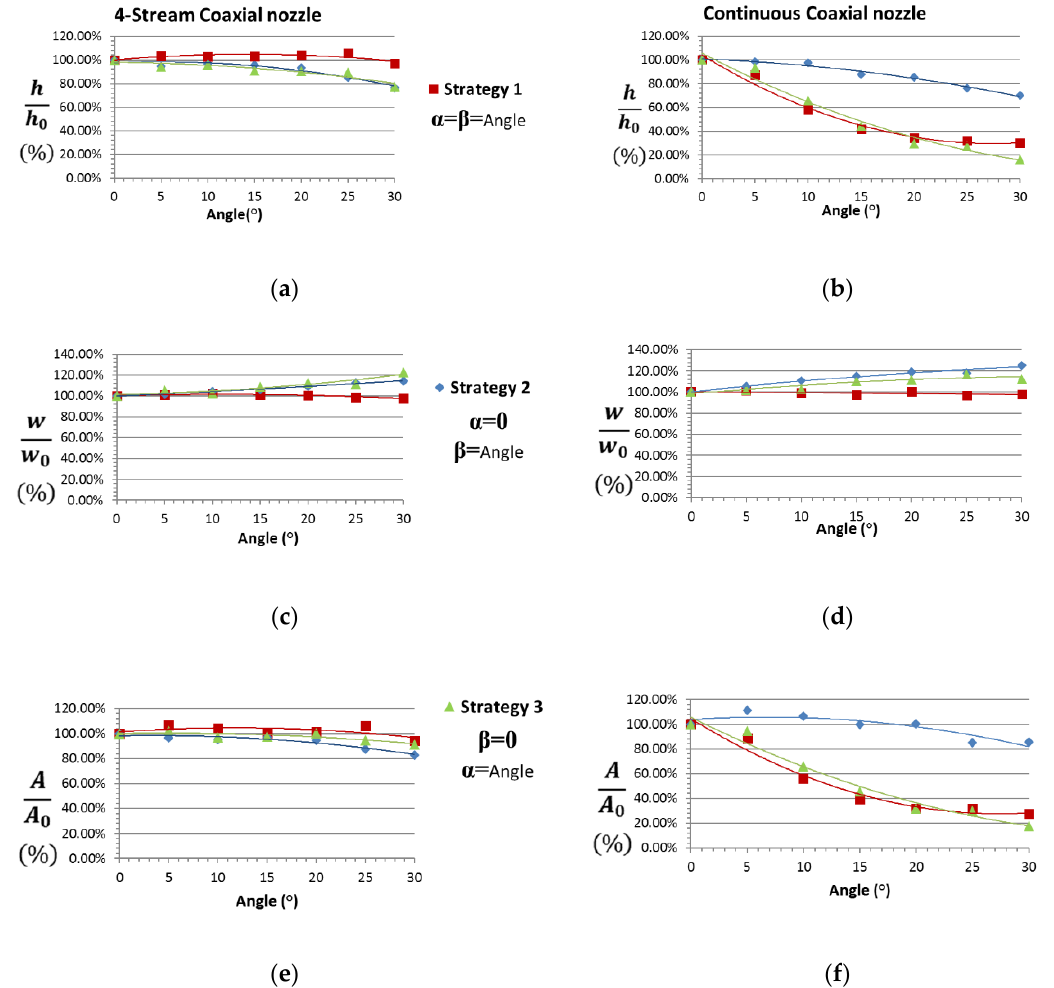
Figure 10. Evolution of the clad dimensions (height, width, and area), in relation to the control clad (α = 0, β = 0), at 500 mm·min −1 : ( a , c , e ) four-stream nozzle; ( b , d , f ) continuous coaxial nozzle.